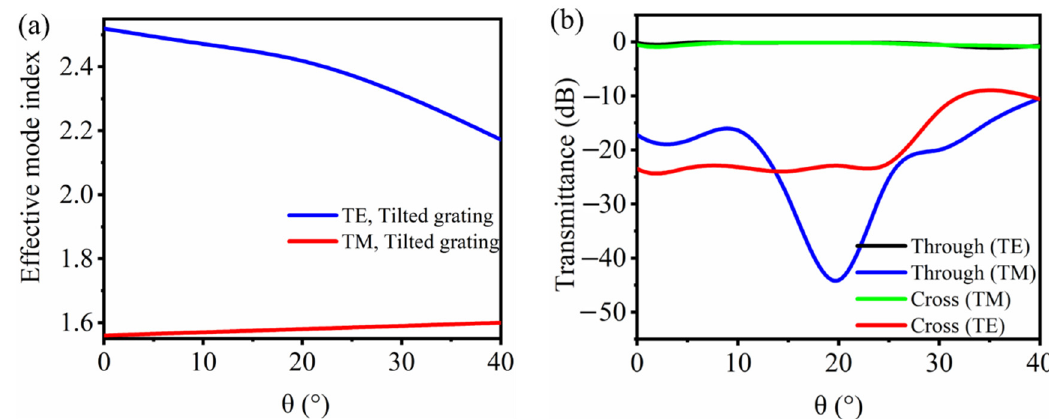
Figure 4. ( a ) Effective mode index for TE and TM modes of the tilted grating waveguide at λ 0 = 1550 nm. ( b ) Simulated transmission spectra for both polarizations under different tilted angles.